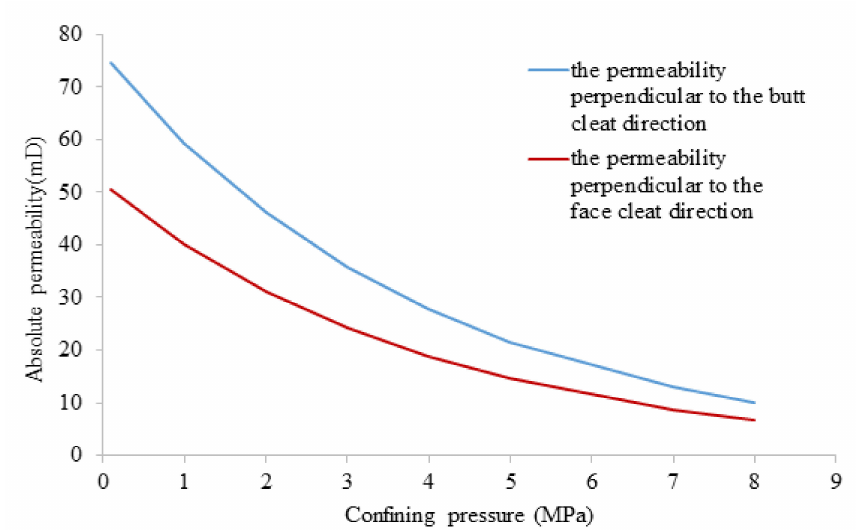
Figure 9. Dependence of coking coal permeability (S. D. Tihov mine, Leninsky area, Kuzbass) (k) on the hydrostatic confining pressure (P) according to the Seidle et al. (1992) model and the microstructural analysis data: the blue solid line corresponds to the permeability perpendicular to the butt cleat direction; the red solid line corresponds to the permeability perpendicular to the face cleat